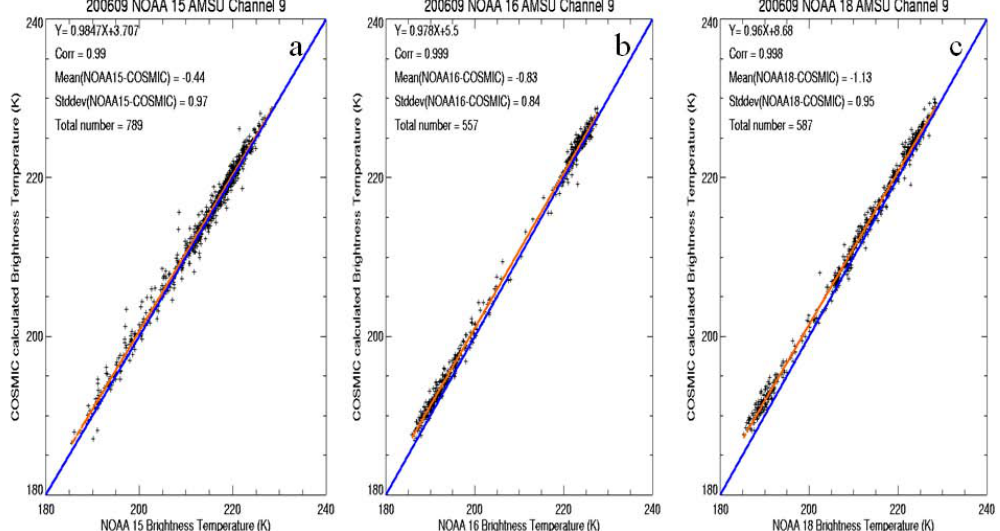
Fig. 33. Use of COSMIC data to calibrate AMSU on NOAA satellites. NOAA 15 brightness temperature (Tb) vs. COSMIC Tb (left); NOAA 16 Tb vs. COSMIC Tb (middle); and NOAA 18 Tb vs. COSMIC Tb (right). Units of Tb in K (Ho et al., 2009a).